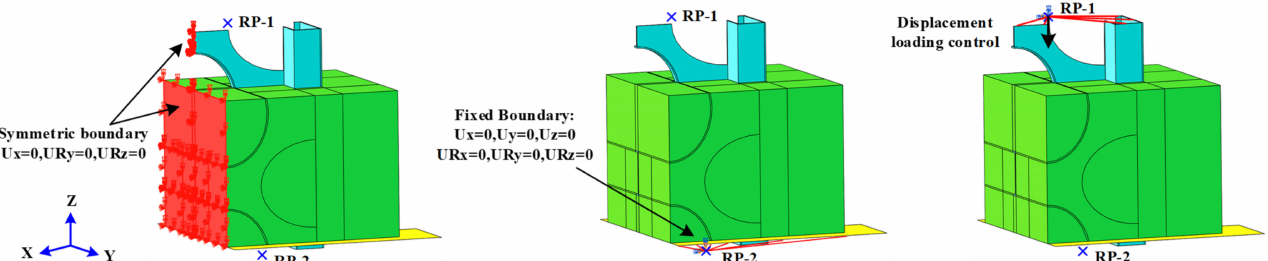
Figure 19. Boundary conditions and loading